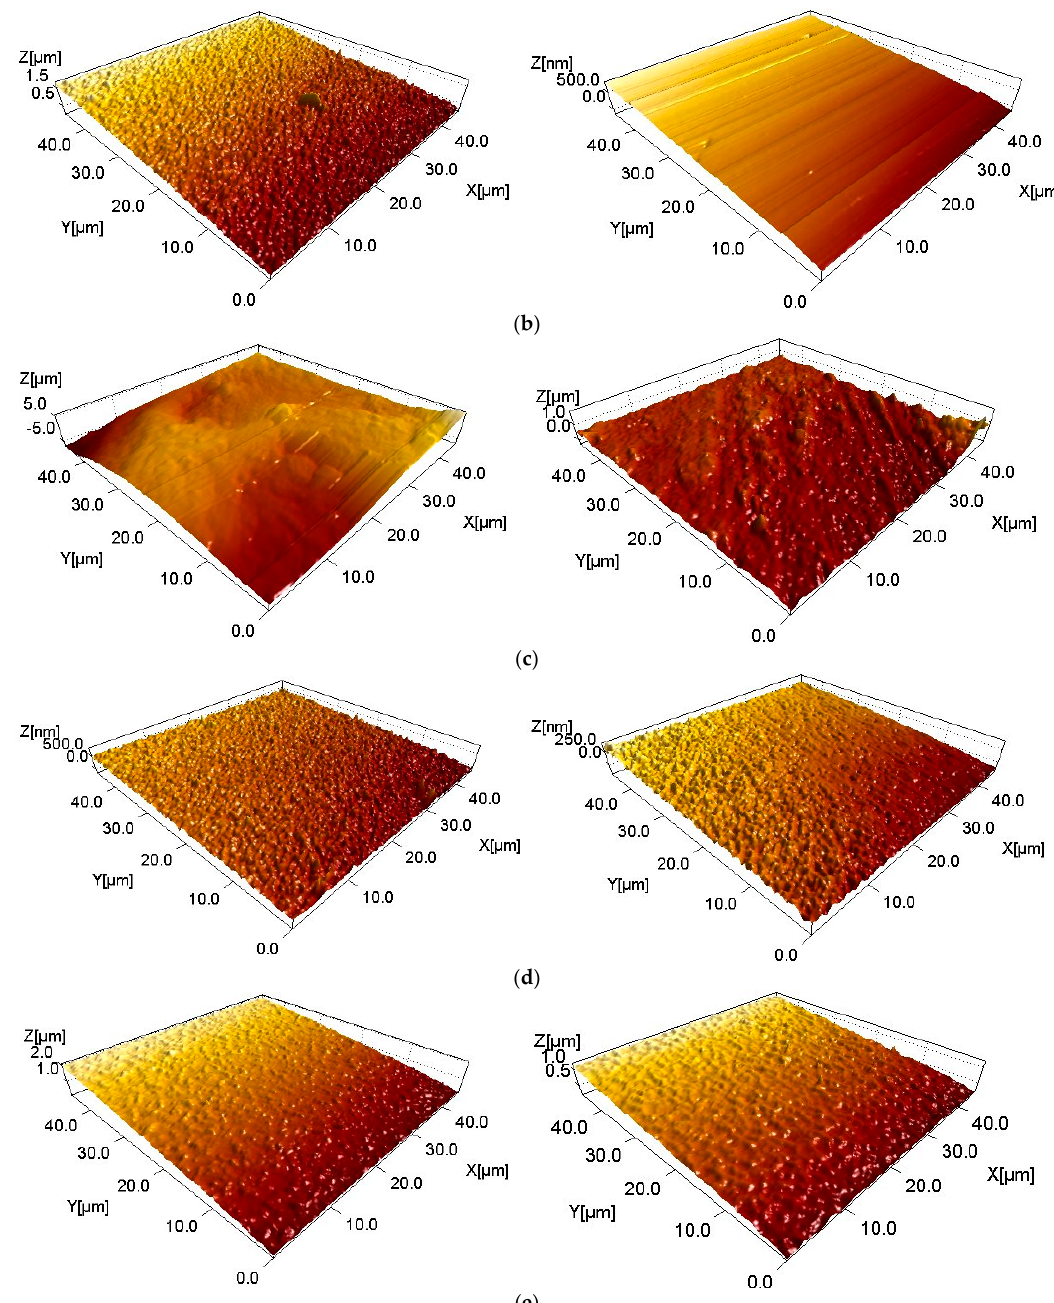
Figure 7. Surface characterization of each sample using AFM technique before and after micro-abrasion test ( a ) Au, ( b ) TaC/Au, ( c ) HfC/Au, ( d ) 30TaC-70HfC/Au, and ( e ) 70TaC-30 HfC/Au.